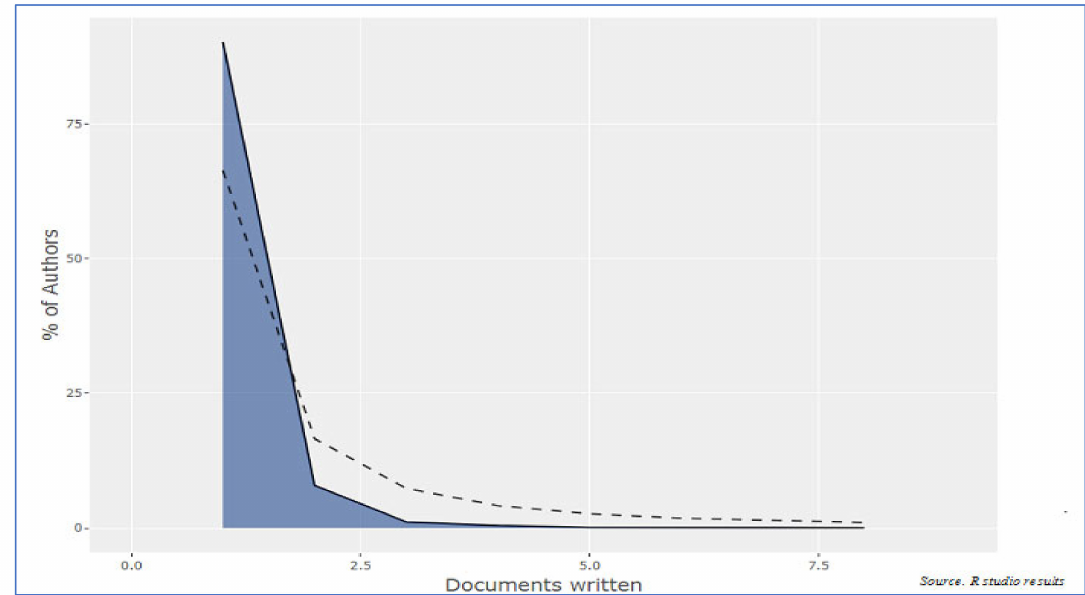
Figure 2. Lotka’s law curve. Source R studio results.